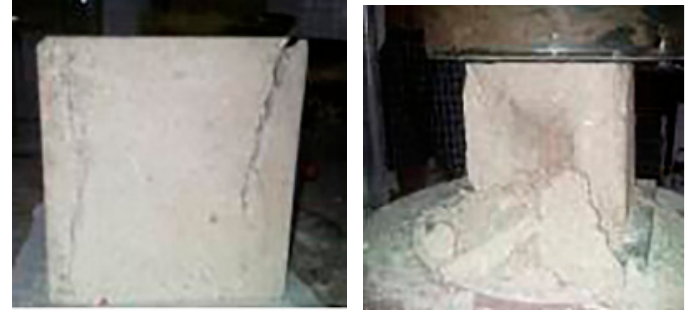
Figure 2. Failure modes of specimens after the compression test.